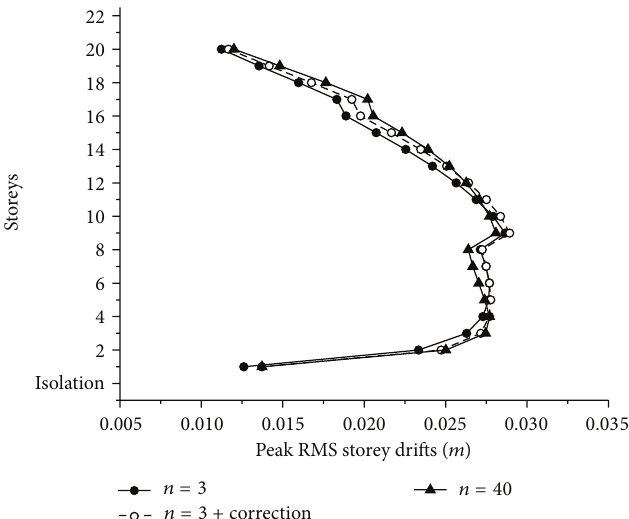
Figure 6: Influence of static correction procedure on the storey drifts.